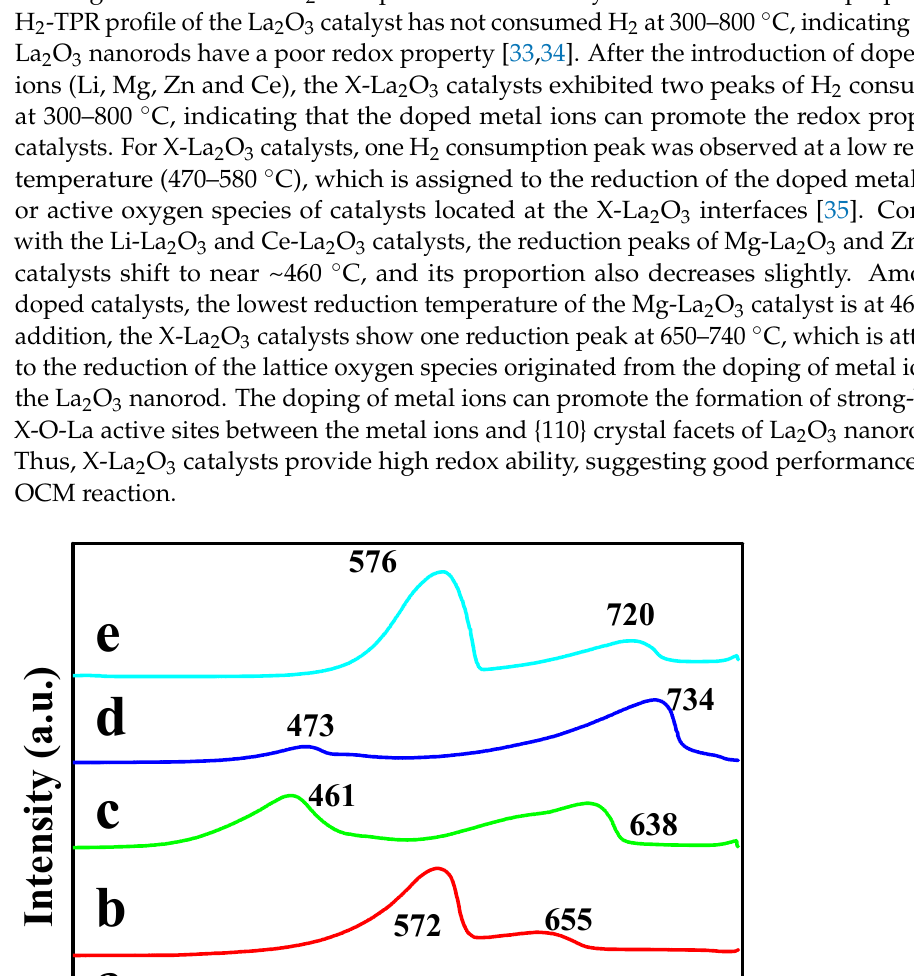
Figure 5. HR-STEM image and HAADF-STEM-EDX element-mapping analyses of La (yellow), O (red), Mg (orange), Zn (purple), Ce (green), ( A ) Mg-La 2 O 3 , ( B ) Zn-La 2 O 3 , ( C ) Ce-La 2 O 3 .